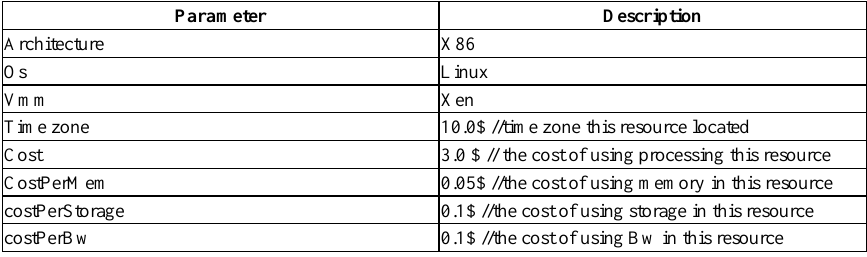
Table 3. DC (Data Center) Specifications